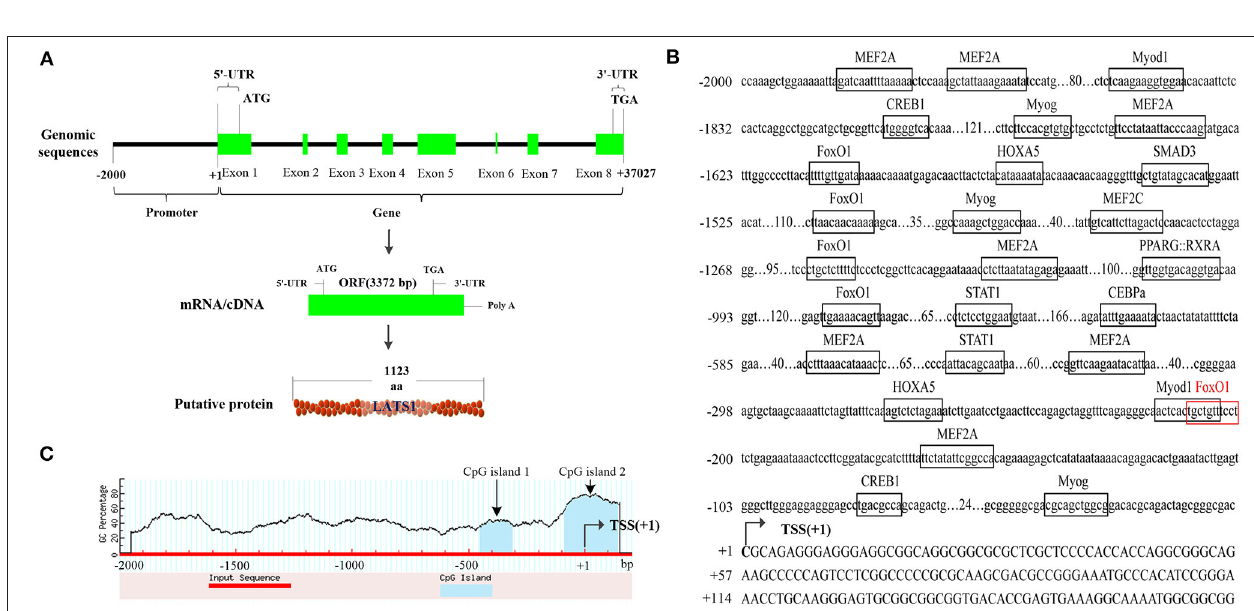
FIGURE 1 | Expression pattern analysis of the bovine large tumor suppressor 1 ( LATS 1). (A) Analysis of the bovine LATS 1 expression pattern in tissues and organs. (B) Expression pattern of the bovine LATS 1 messenger RNA (mRNA) in longissimus thoracis at different developmental stages. The value of each column represents the mean ± SD of three independent experiments. Different uppercases and lowercases represent p < 0.01 and p < 0.05, respectively.